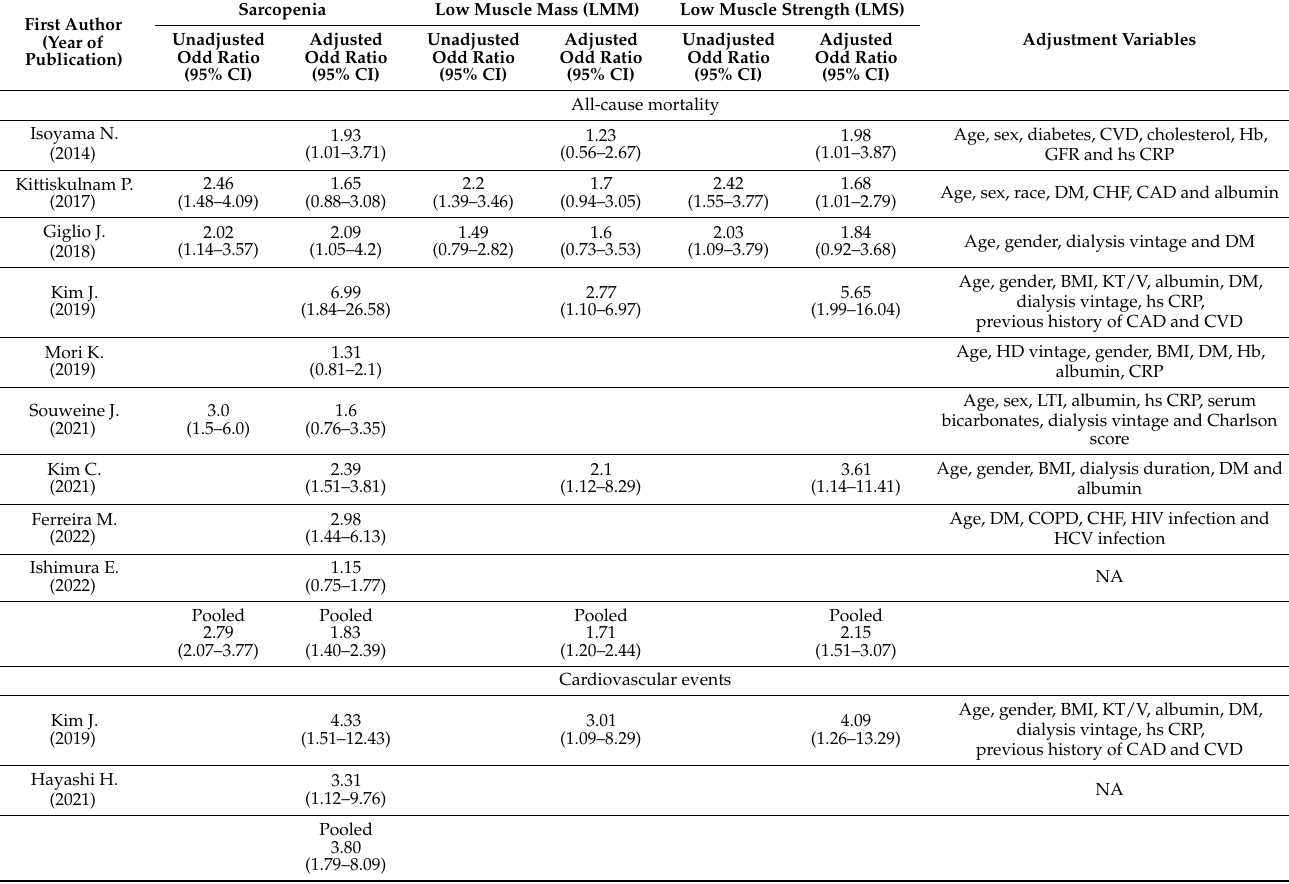
Table 4. The association of sarcopenia, low muscle mass (LMM) and low muscle strength (LMS) with all-cause mortality and CV events among dialysis patients.